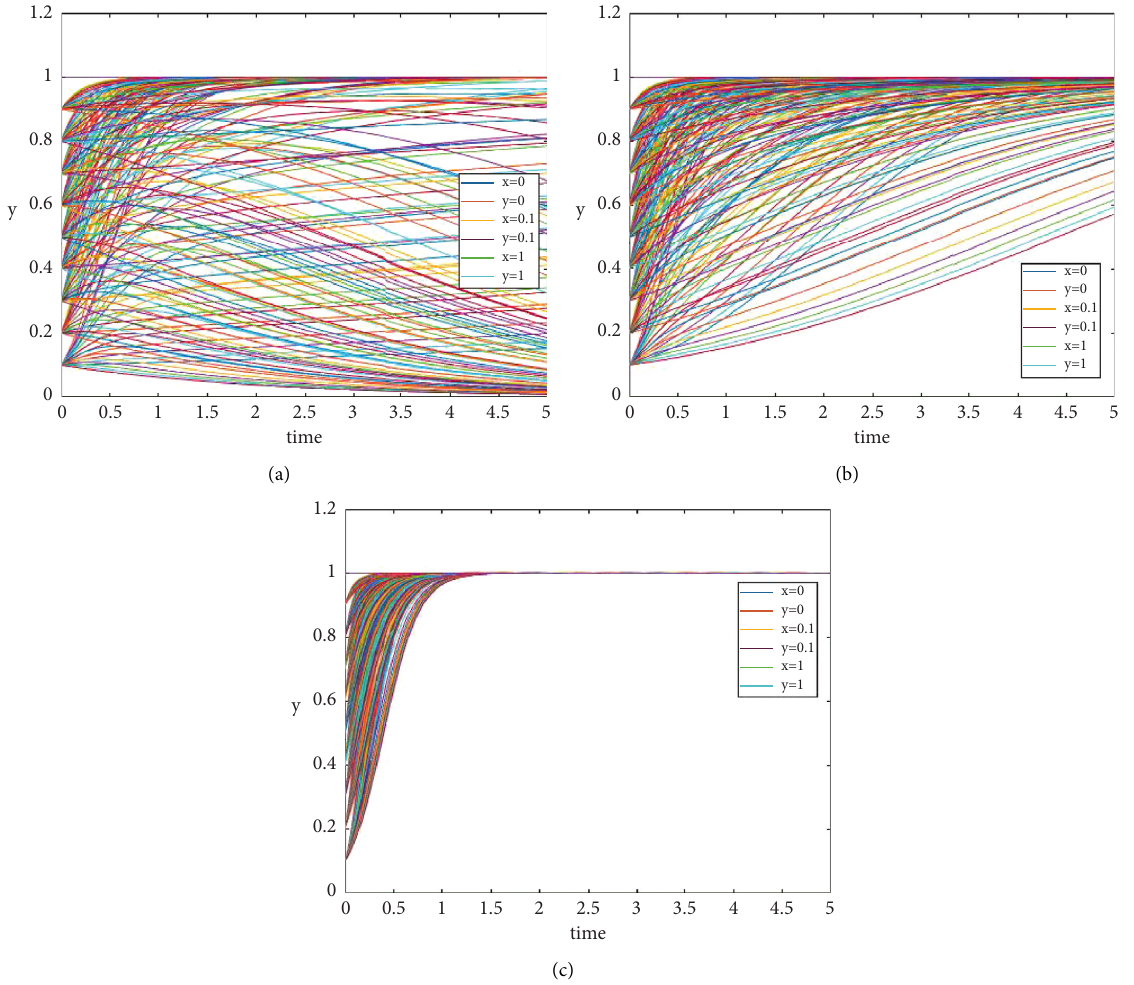
Figure 10: The stability of the air pollution control alliance restricted by the central government in the region under different